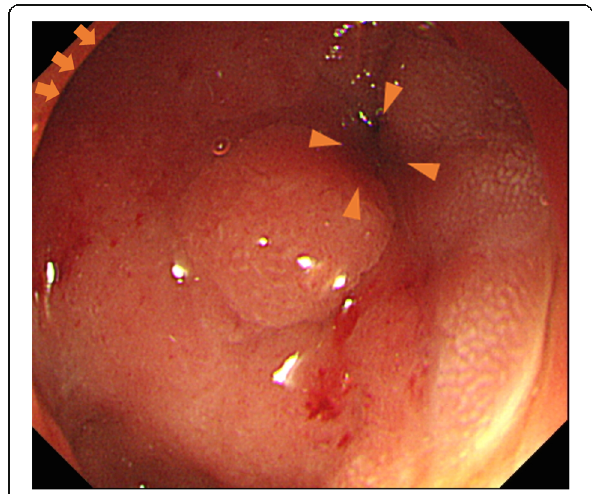
Fig. 1 Esophagogastroduodenoscopy showing the obstruction at the first part of the duodenum. Arrow: pylorus ring. Arrow head: obstruction of the first part of the duodenum